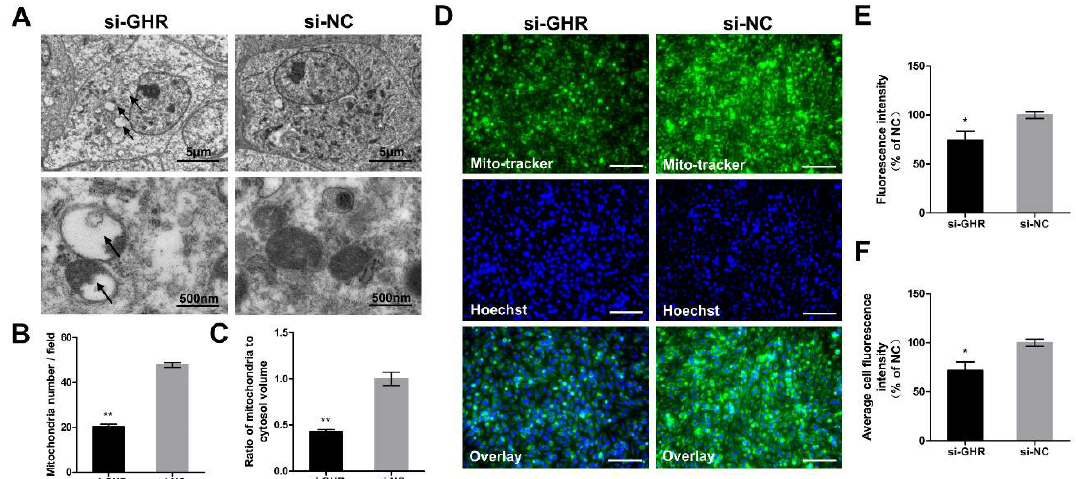
Figure 7. Knockdown of GHR altered mitochondrial structure and reduced mitochondrial number in DF-1 cells. ( A ) Mitochondrial ultrastructure was imaged by TEM at 48 h after transfection with si-GHR and si-NC fragments in DF-1 cells, and abnormal mitochondria are indicated by black arrows. ( B ) The number of mitochondria and ( C ) the ratio of mitochondria to cytosol volume as determined from TEM images were assessed in DF-1 cells ( n = 5). ( D ) MitoTracker staining of DF-1 cells was measured at 48 h after transfection with si-GHR and si-NC fragments in DF-1 cells. Bar, 100 μm. ( E ) Fluorescence intensity of MitoTracker staining and ( F ) average cell fluorescence intensity of MitoTracker staining were assessed in DF-1 cells. Data are expressed as means ± SEM, * p < 0.05; ** p < 0.01; *** p < 0.001.